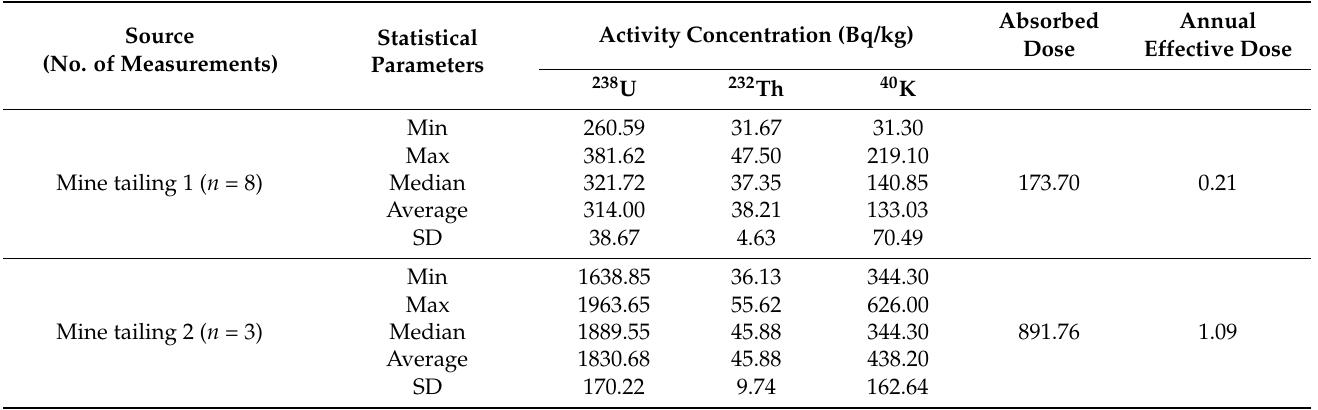
Table 1. In situ activity concentration of 238 U, 232 Th, and 40 K in the gold mine tailings of the West Rand area and the corresponding absorbed dose and effective